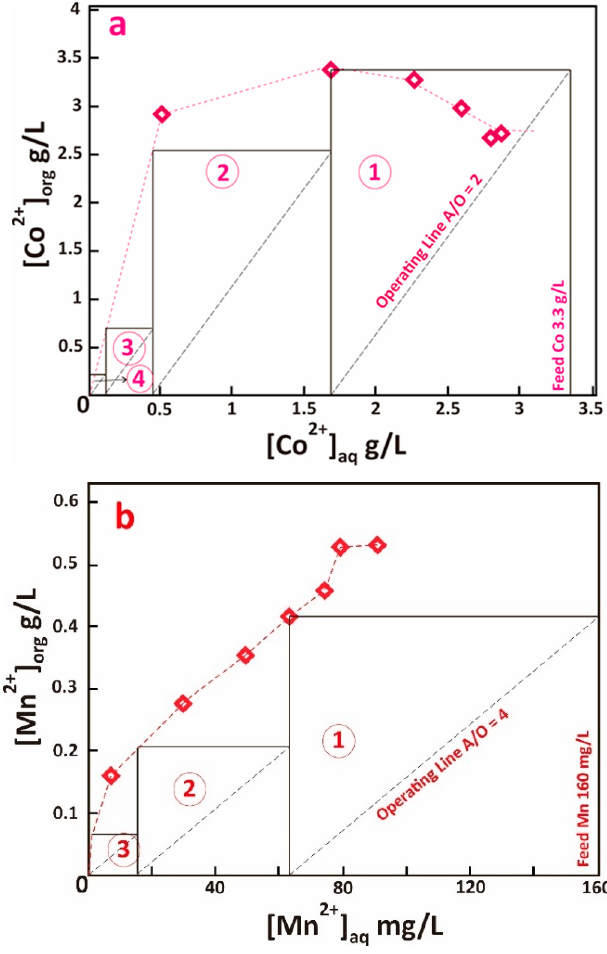
Figure 4. Effect of Cyanex ® 272 concentration ( v/v ) on Co-Mn co-extraction from raffinate (pH 5,